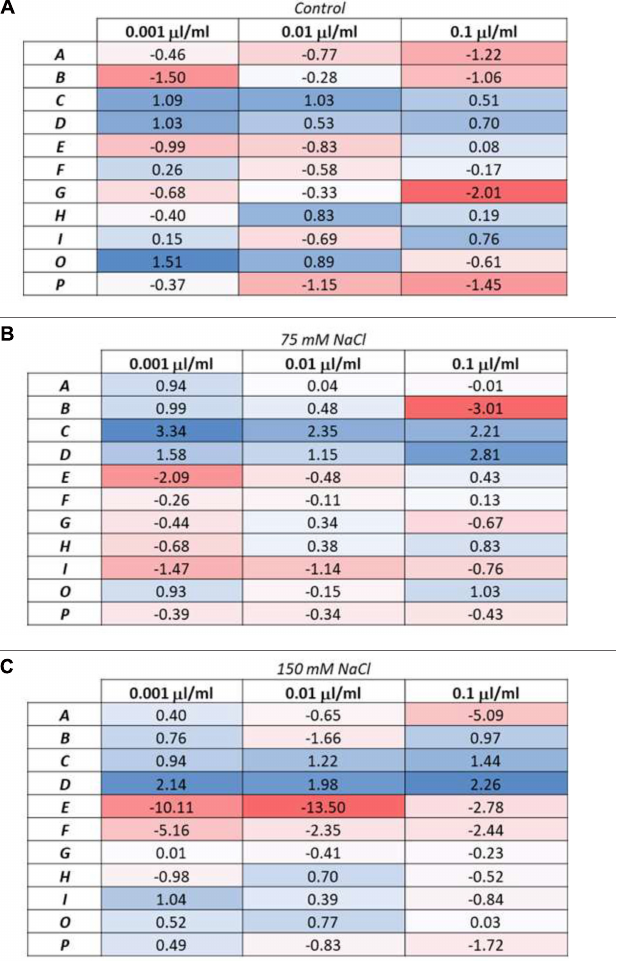
TABLE 1 | Plant biostimulant characterization (PBC)